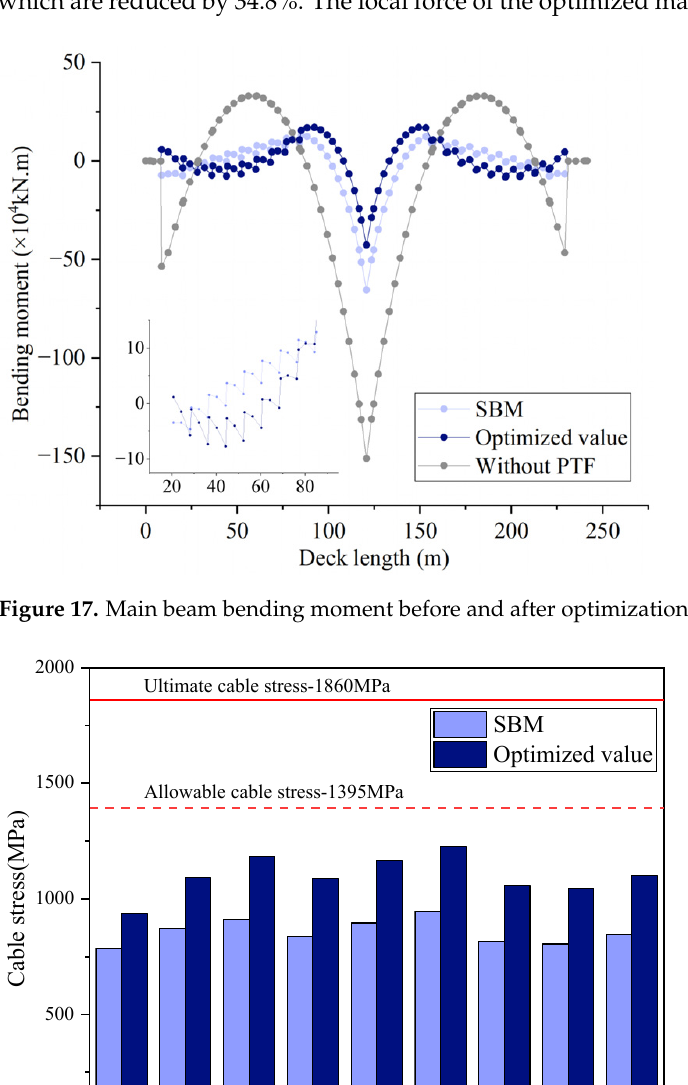
Figure 16. Vertical displacement of the optimized main beam.